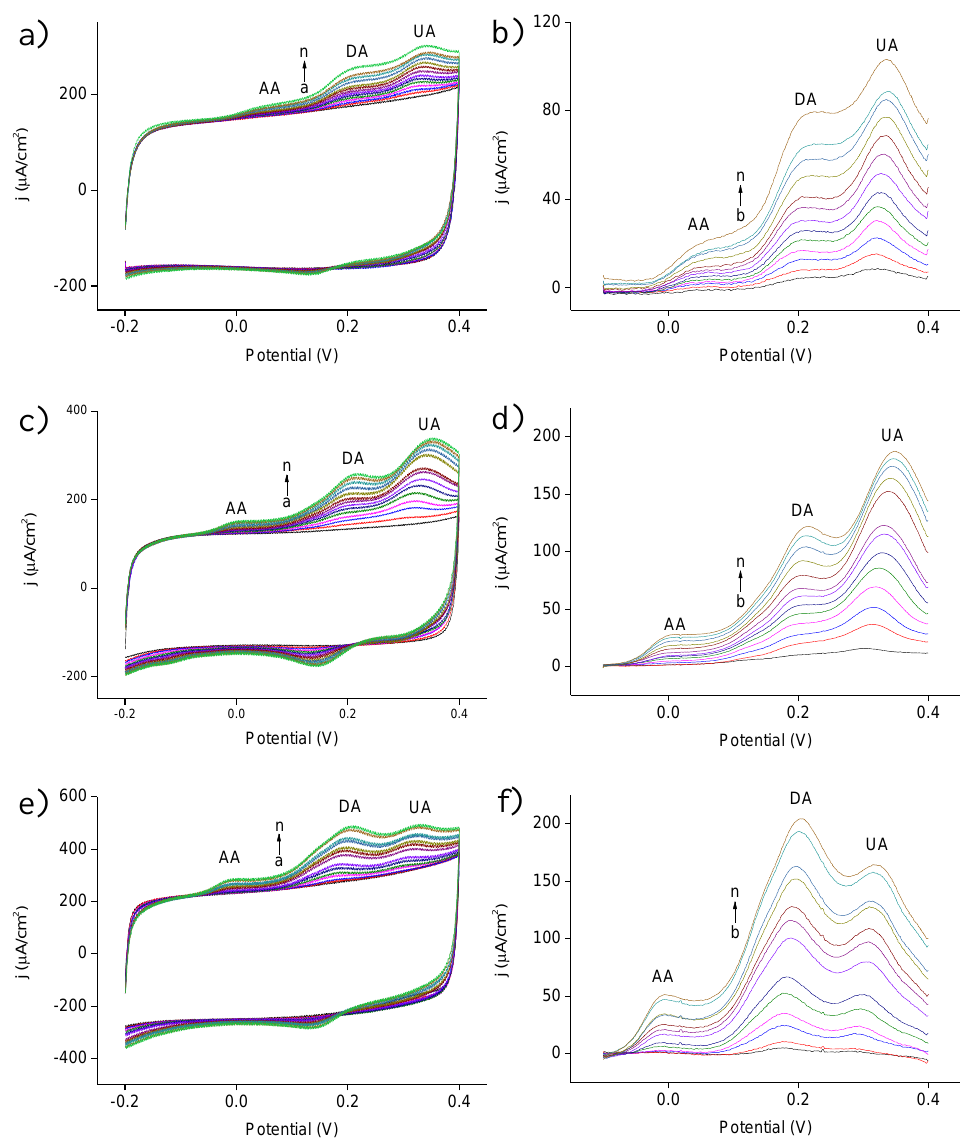
Figure 9. The CV profiles for ( a ) planar Ni@PEDOT film, as well as ( c ) Ni@PEDOT and ( e ) Ni@PEDOT / Au inverse opals, respectively. The electrolyte is 0.1 M PBS containing various concentrations of AA (0–194 µ M), DA (0–194 µ M), and UA (0–134.4 µ M). The exact compositions of individual electrolytes are listed in Table 3. The corresponding background-subtracted CV profiles are displayed in ( b ), ( d ), and ( f ), respectively.